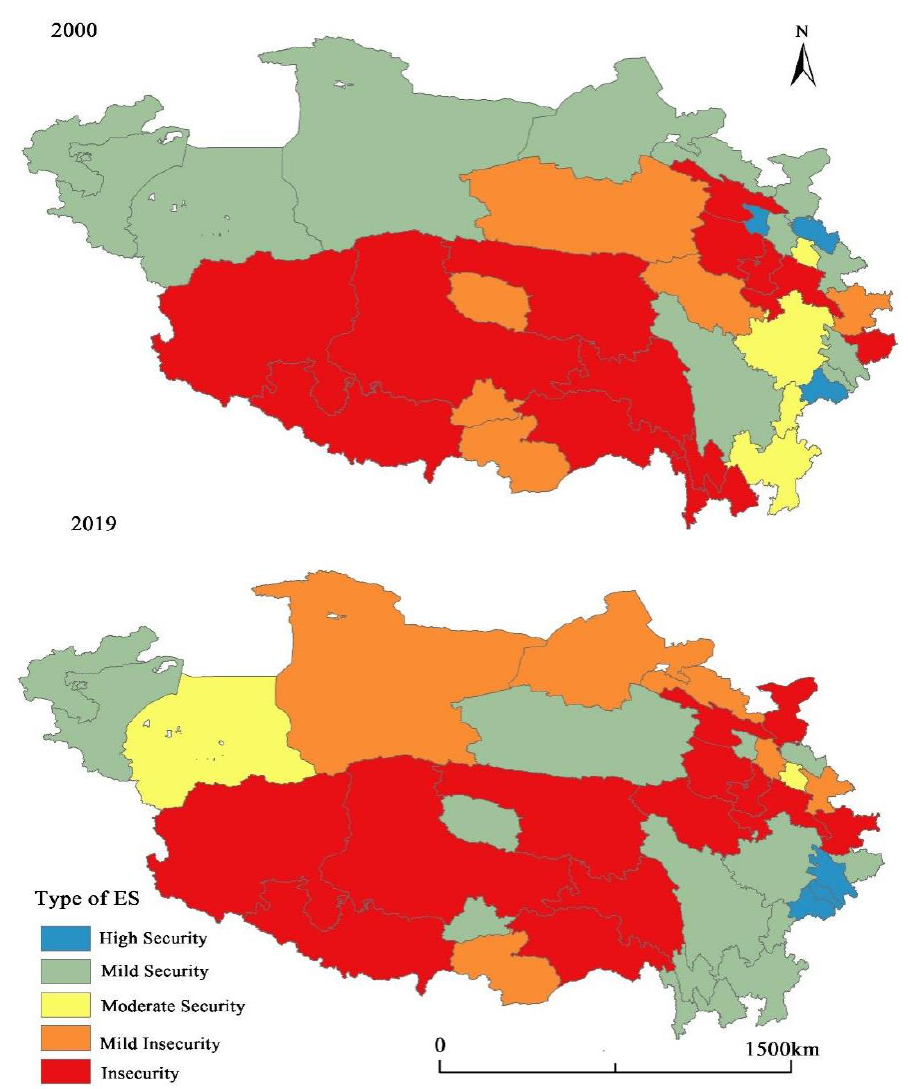
Figure 8. Spatial Pattern of Economic Security Types of Prefecture-level Cities in the Qinghai – Tibet Plateau in 2000 and 2019. Plateau in 2000 and